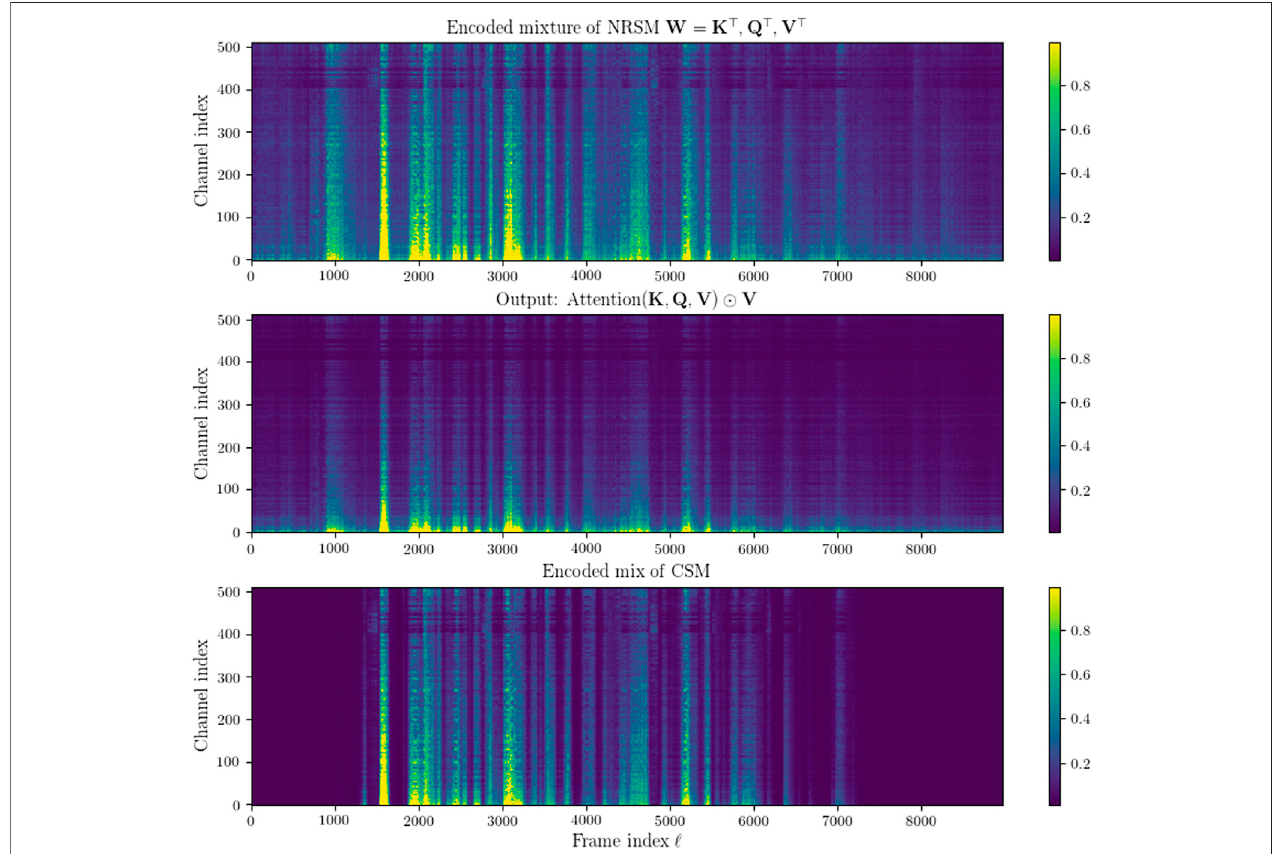
FIGURE5| Top:EncodedNRSMsignalblocks.Middle: EncodedNRSMsignalblocksre-weighted withattention asde fi nedin (24) .Bottom:EncodedCSMsignal blocks( ] ( t )=0, h c ( t )= δ ( t ), ∀ t ≥ 0).Thetopandbottom fi guresclipvaluesabove0.05×themaximumvalueoftheencodedNRSMsignalandthennormalizedbetween0and 1. The middle fi gure clips values above 0.05× its maximum value and is then normalized between 0 and 1.